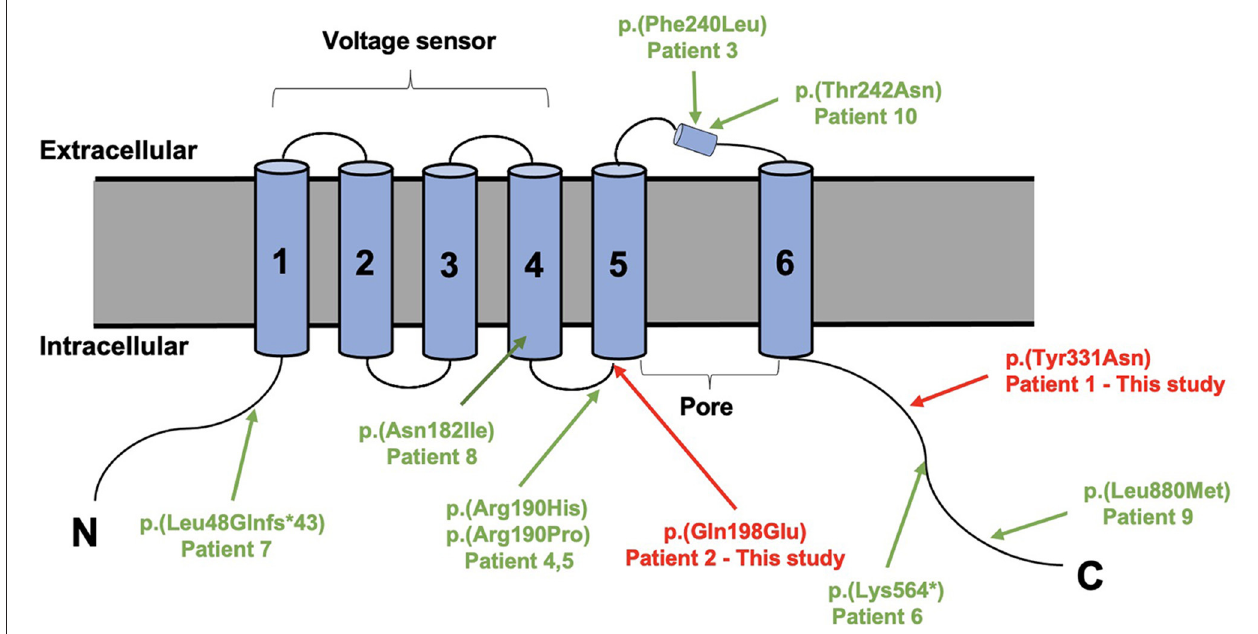
FIGURE 3 | Structure of the sodium-activated potassium (K Na 1.2) channel (9606 [NCBI]) with all variants published variants in KCNT2